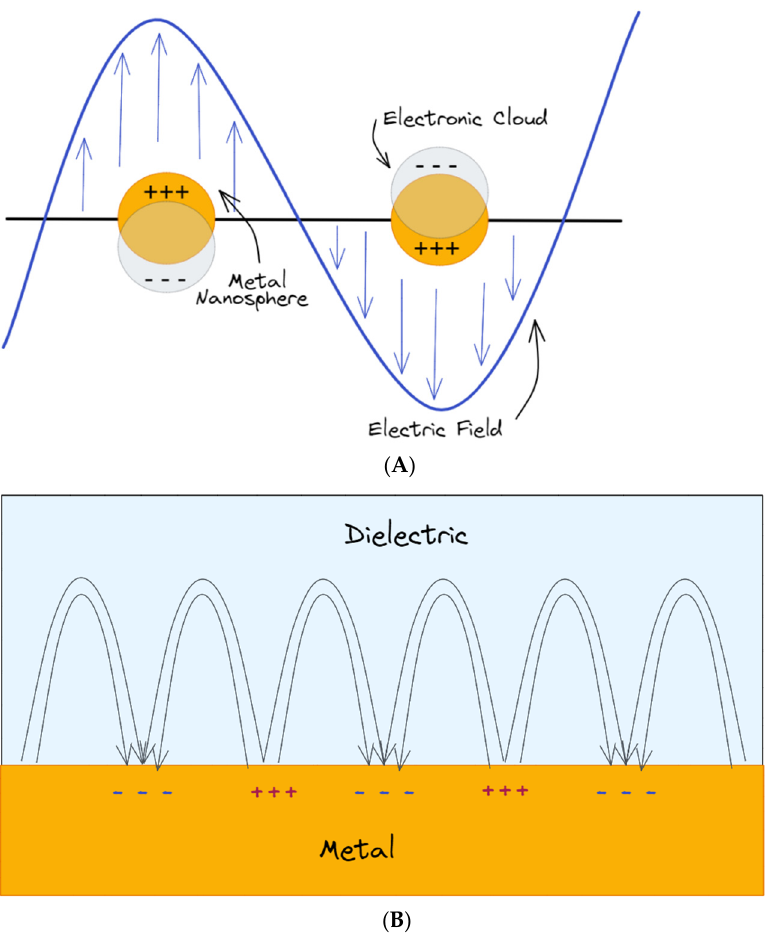
Figure 2. ( A ) Schematics of metal nanoparticles with their LSPR when placed in a static electromagnetic (EM) field; ( B ) collective charge oscillations (SPPs) at the interface between the dielectric medium and the metal.